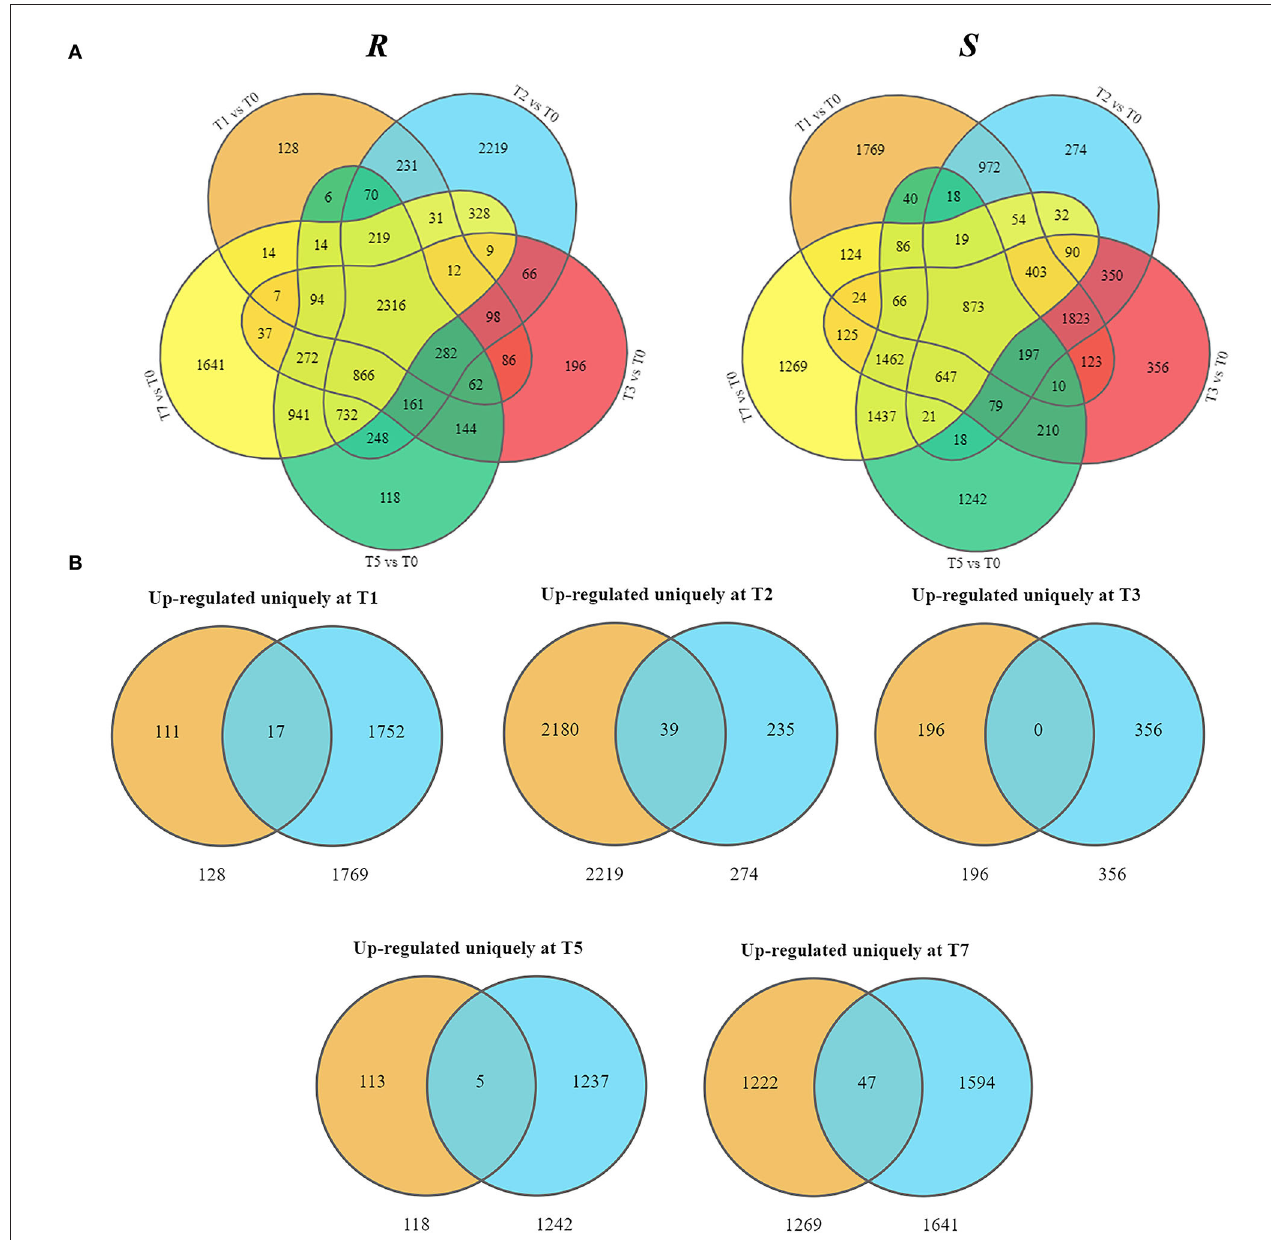
FIGURE 3 | Presentation of upregulated DEGs in R and S at five time points post-inoculation (T1, T2, T3, T5, and T7). (A) Overlap analysis of upregulated DEGs. (B) Uniquely upregulated DEGs in R compared with S .